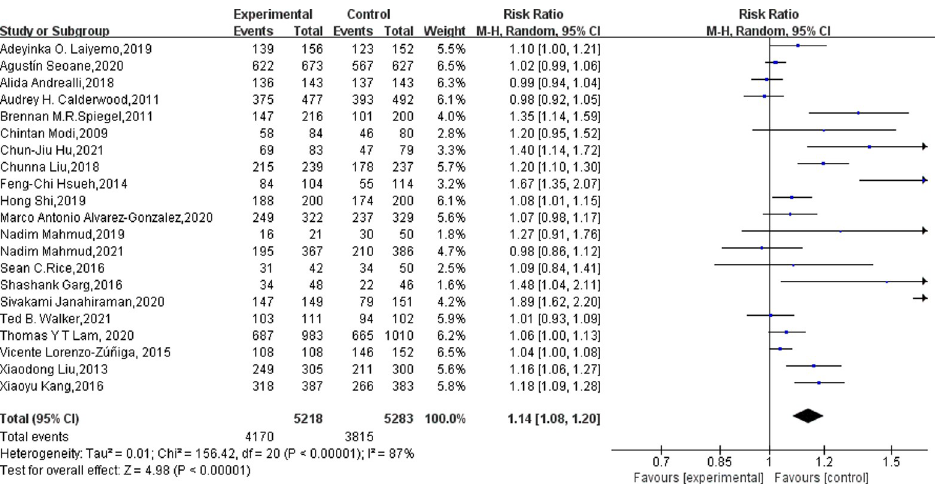
Fig 4. Forest plot comparing the effects of supplementary education based on traditional education and traditional education alone on the adequate bowel preparation rate.